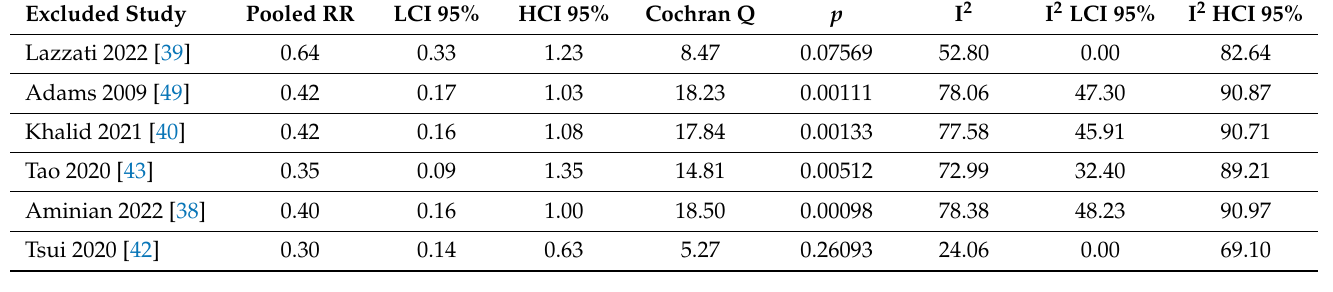
Table A15. Gallbladder cancer random effects model sensitivity analysis.